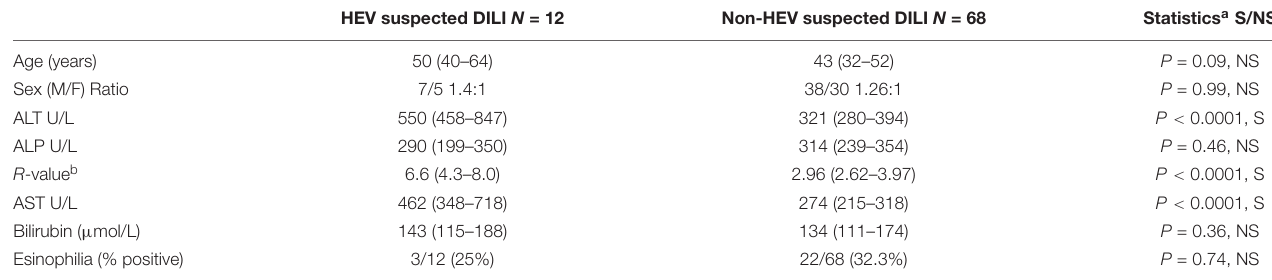
TABLE 1 | Demographic and laboratory criteria and hepatitis E virus (HEV) and non-HEV suspected drug-induced liver injury (DILI). HEV suspected DILI N = 12